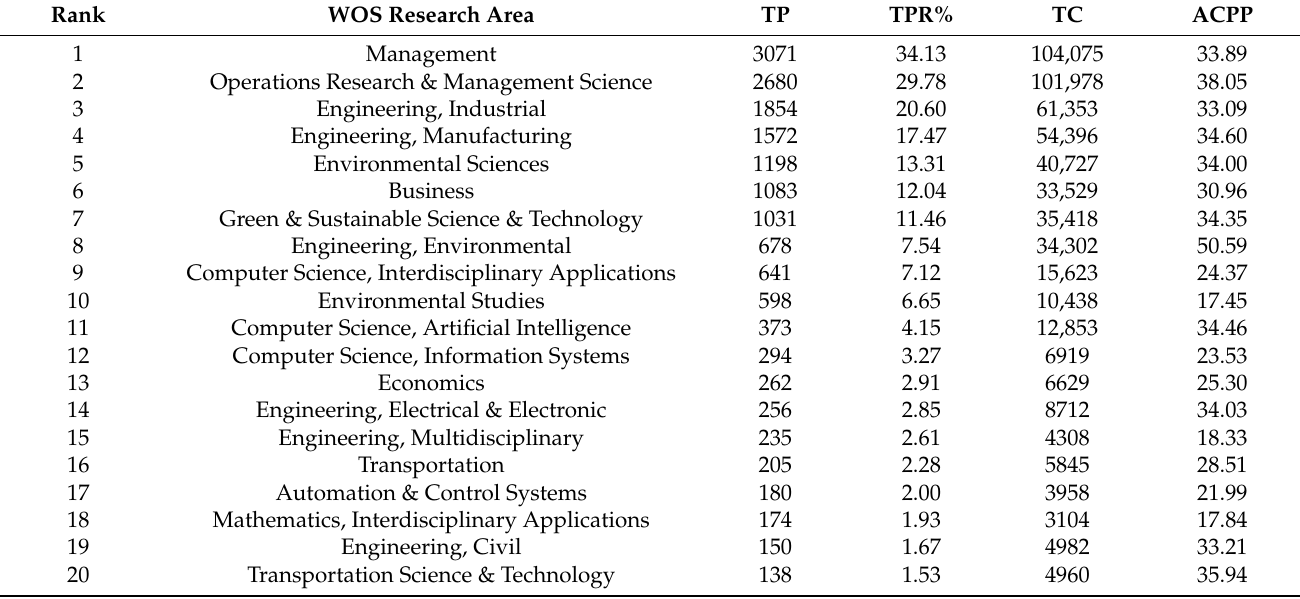
Table 1. Contribution of the top 20 WoS research areas in